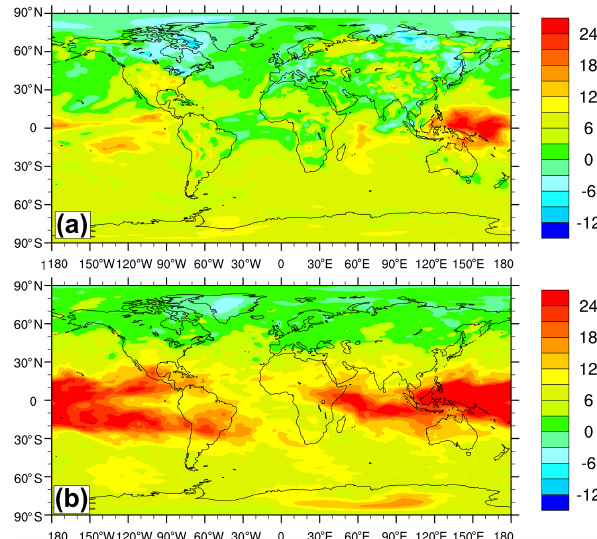
Figure 11. Mean relative difference (%) between the global annual- mean ozone mixing ratios predicted by Run 2 using the new light- ning flash-rate parameterisations from this study and the default PR92 parameterisations (Run 1): (a) at 20m (the lowest model level) and (b) at 6400m ( ∼